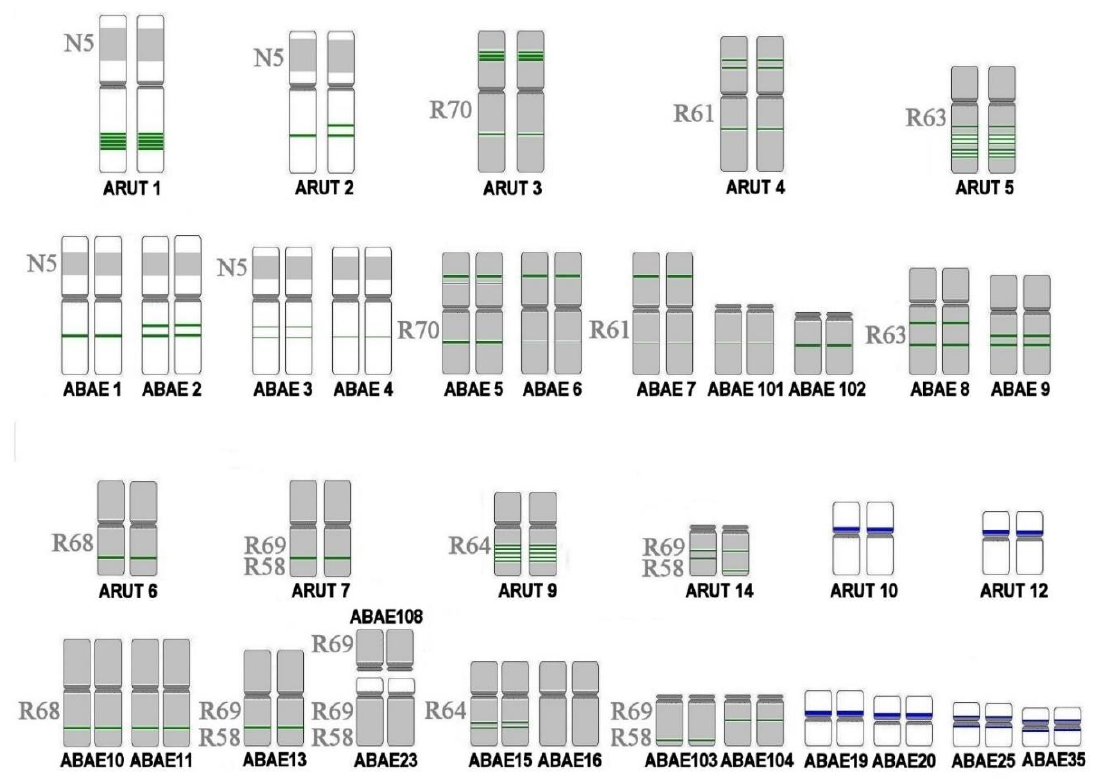
Figure 7. Schematic distribution of the repeat Arut434A (green), small nuclear RNA gene cluster U2 (blue), and chromosome-specific probes (grey) on the orthologs of 11 sterlet chromosomes in the Siberian sturgeon karyotype.